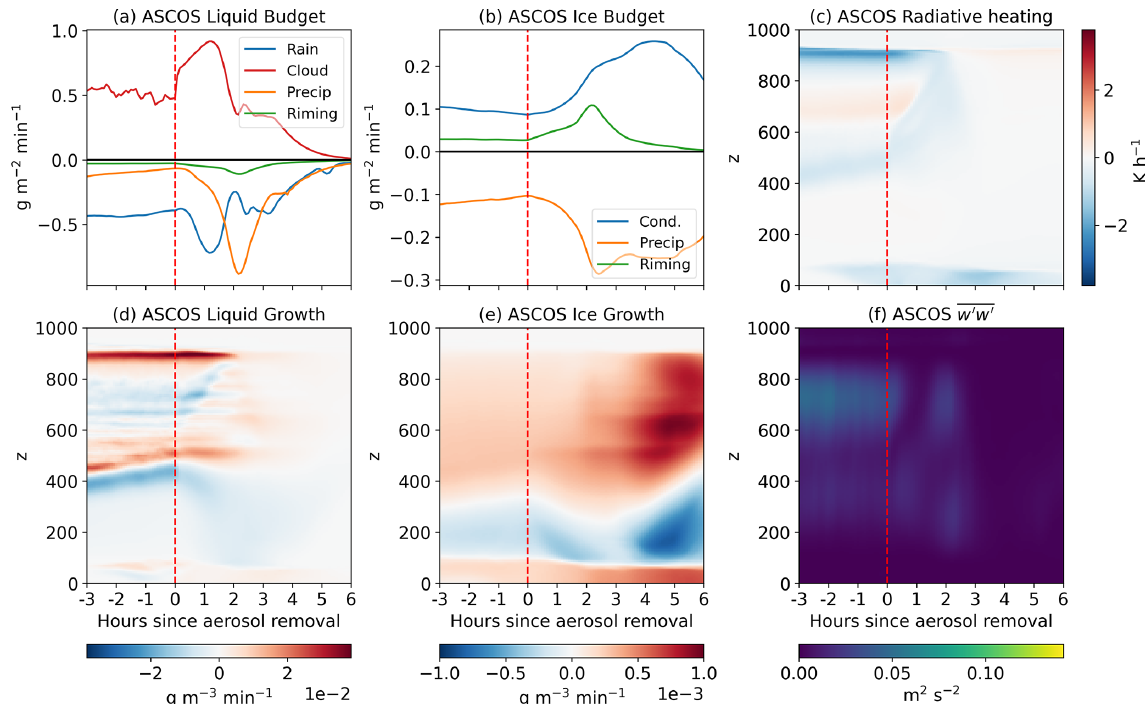
Figure 8. Same as Fig. 7 for